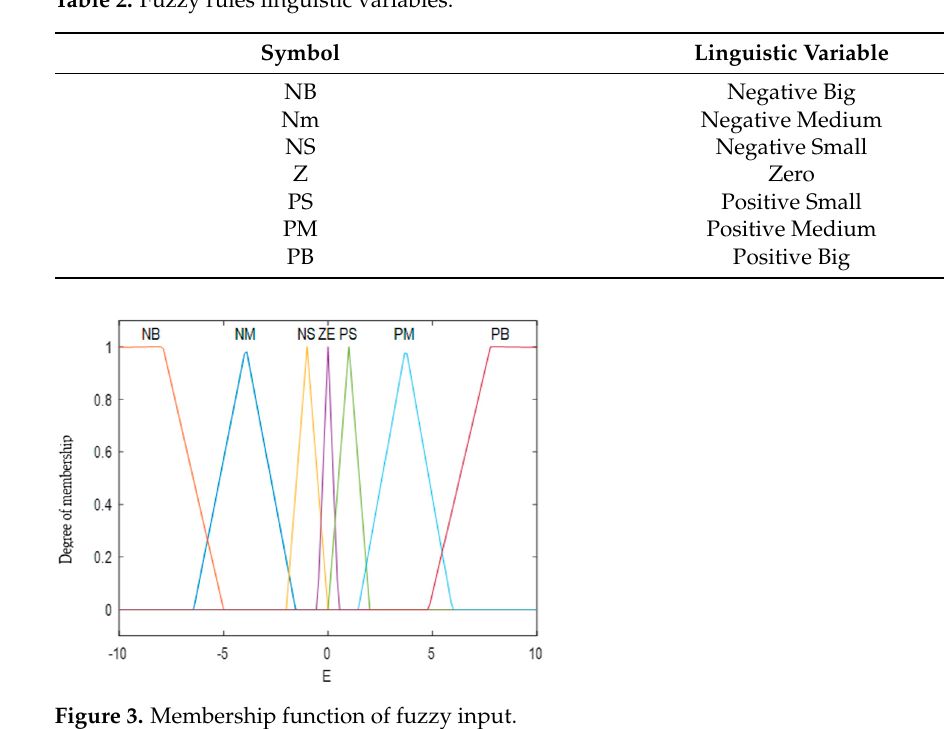
Table 2. Fuzzy rules linguistic variables.